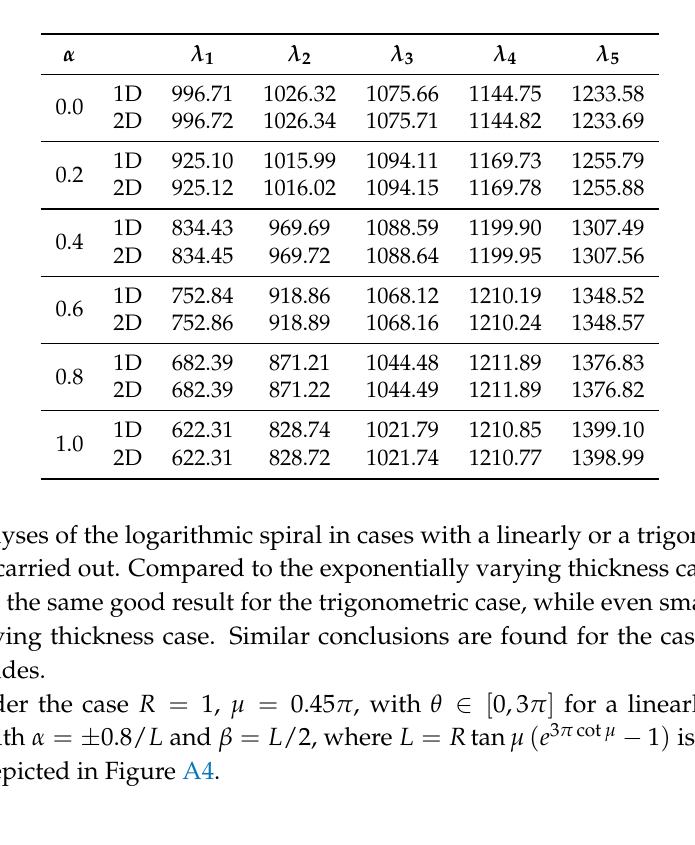
, (cid:101) = 0.05. Calculated using both 1D and e α − 1